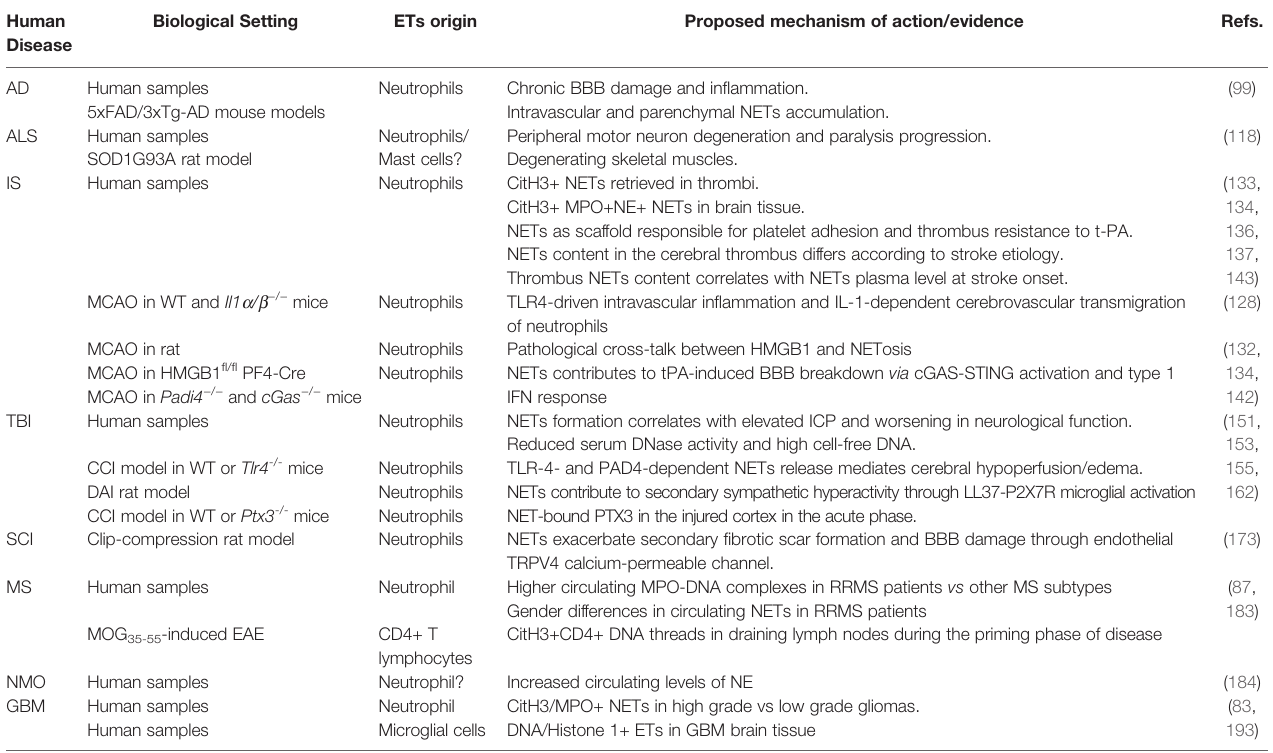
TABLE 1 | ETs in the pathogenesis of CNS disorders. Human Biological Disease